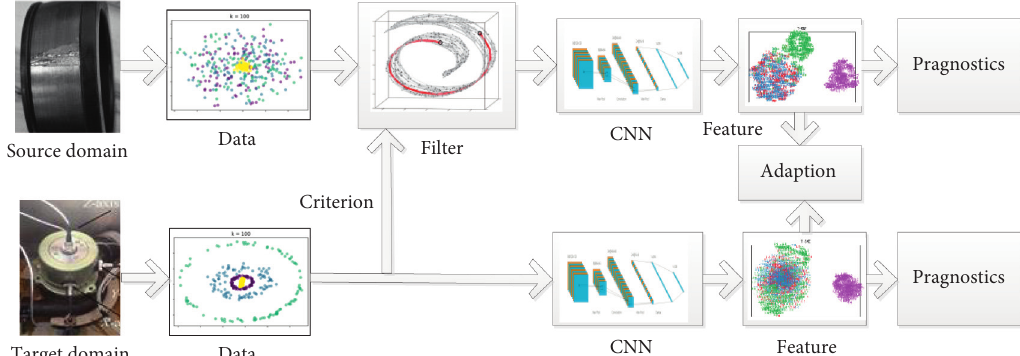
Figure 2: The framework of the proposed model.